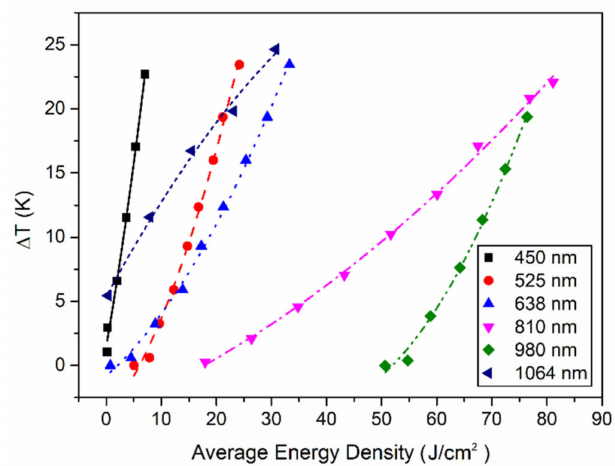
Figure 6. The temperature rises versus the average energy density of the lasers with different wavelengths at the pulse frequency of 500